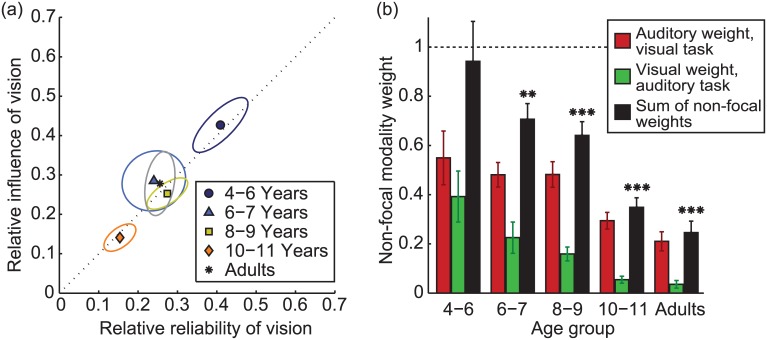
Sensory weights.(a) The relationship between the relative reliability of vision and the relative influence of vision, for each age group. It is clear that the relative reliability of vision predicts its relative influence for all groups. Covariance ellipses give 1SE around the mean. Note that the relative reliability of audition, rrA, and the relative weight for audition, rwA can be calculated in an analogous way such that rrA = 1 − rrV and rwA = 1 − rwV. Thus, the relative reliability of audition predicts the relative weight for audition in exactly the same way as for vision. (b) Sensory weights for non-focal modalities. Red bars give the weight given to (task-irrelevant) auditory information when reporting the number of flashes, while green bars give the visual weight when estimating the number of beeps. Black bars show the amount of integration, as quantified by the sum of the weights given to non-focal cues. Asterisks show the groups for which this sum is significantly less than 1 (one-sample t-tests).